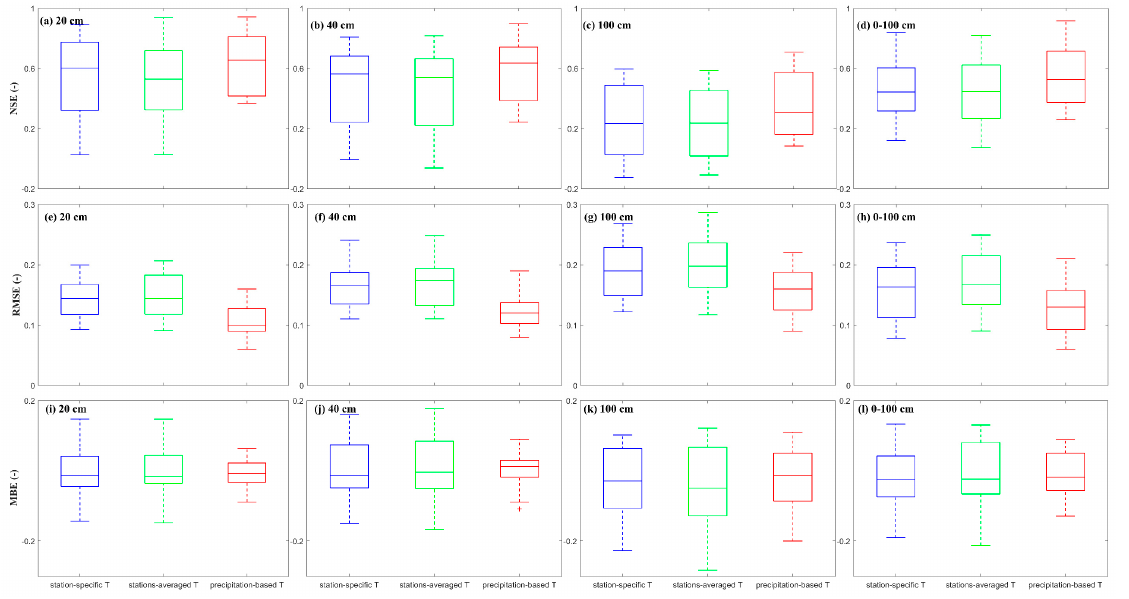
Figure 6. Box plots of NSE ( a – d ), RMSE ( e – h ) and MBE ( i – l ) at depths of 20 cm, 40 cm, 100 cm and for the profile average value for the station-specific T, stations-averaged T and precipitation-based T. Table 2. Statistical metrics of NSE, RMSE and MBE at depths of 20, 40, 100 cm and profile average value, calculated with observed SWI o standardized by daily volumetric soil moisture and predicted SWI m from normalized near-surface soil moisture with the exponential filter.